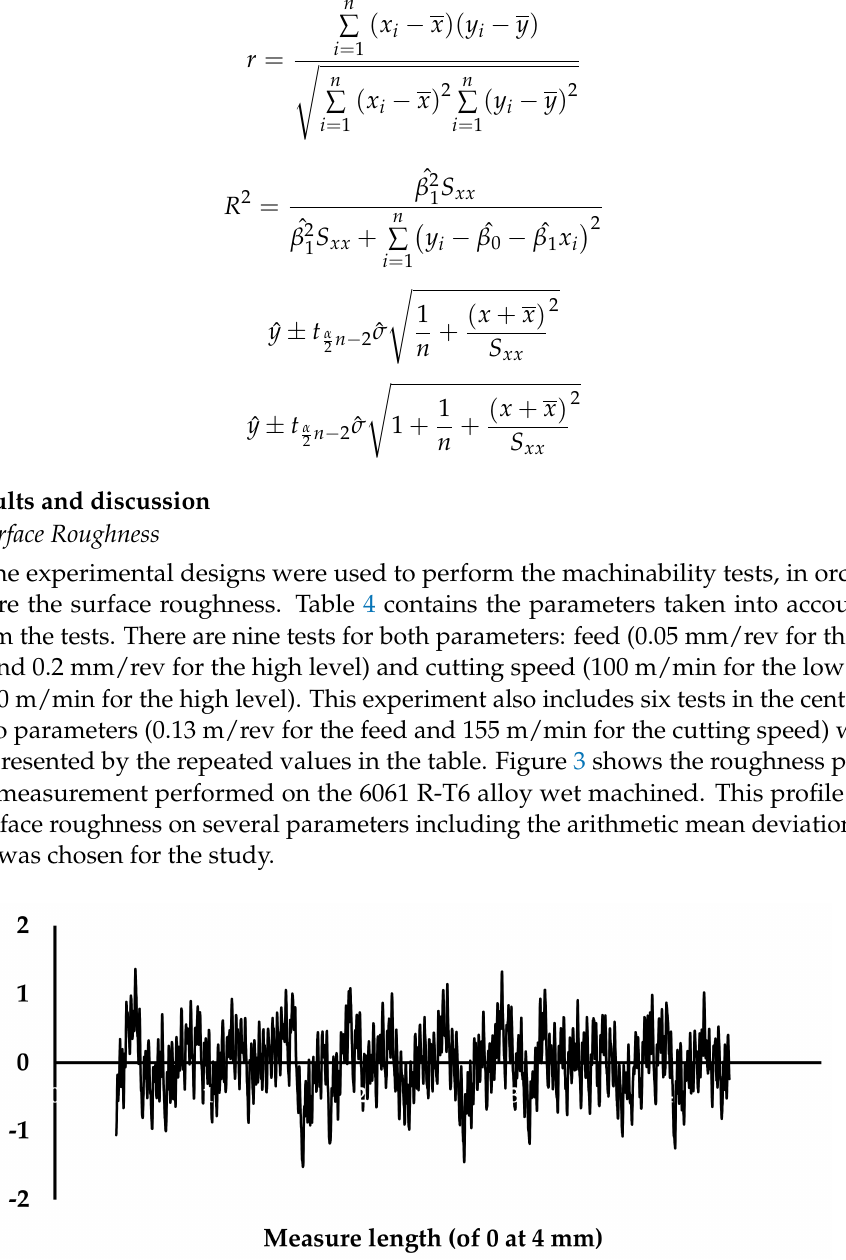
Figure 3. Roughness profile measured on wet machined 6061 R-T6